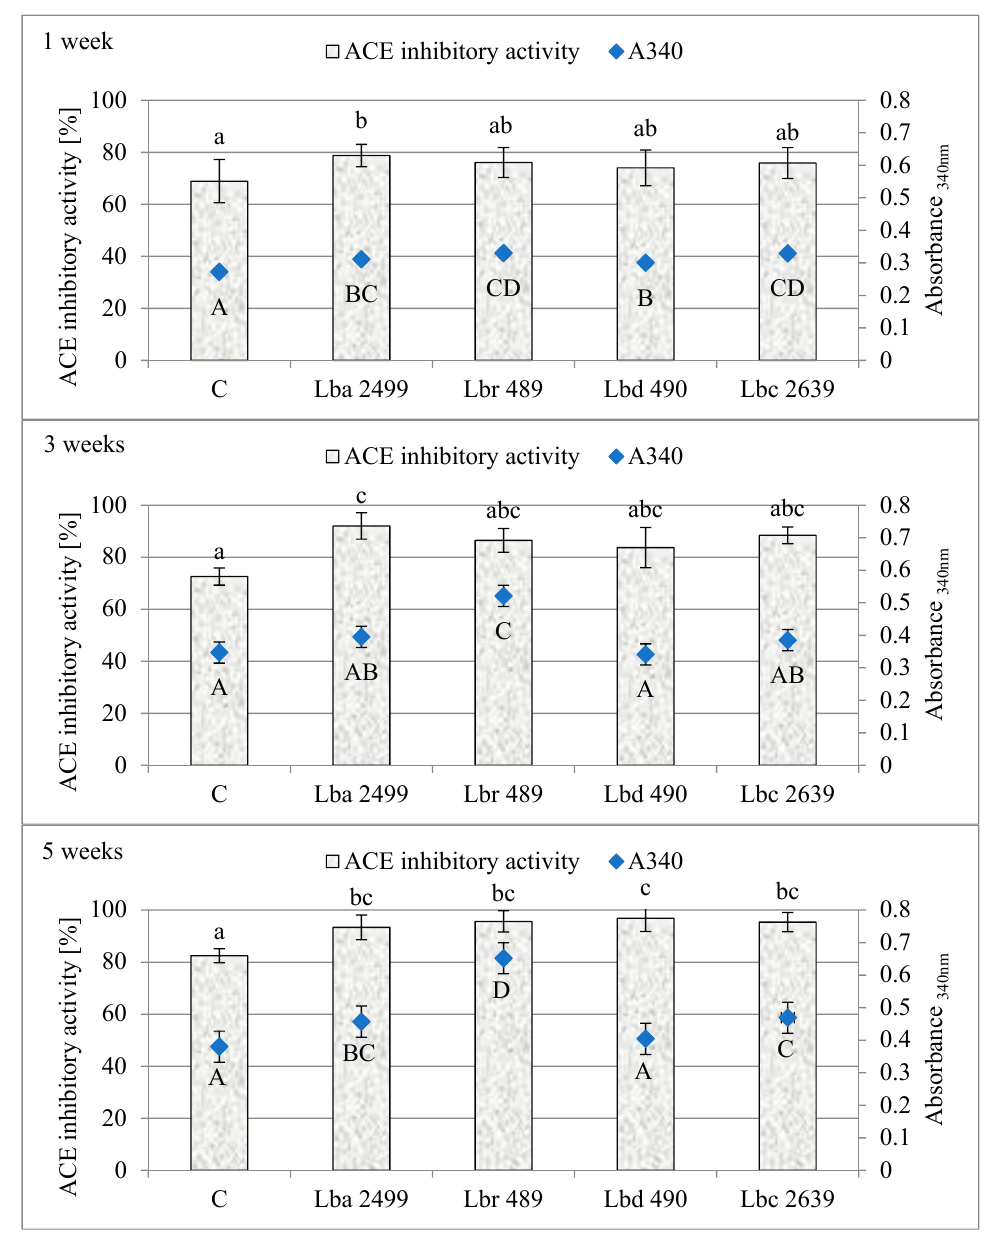
Figure 2. Angiotensin-converting enzyme (ACE) inhibitory activity (%) and proteolysis of water soluble extract (WSE) from Dutch-type cheese models during ripening (mean values and standard deviations). a–c: homogenous groups ACE, n = 6; A–D: homogenous groups proteolysis, n = 6.